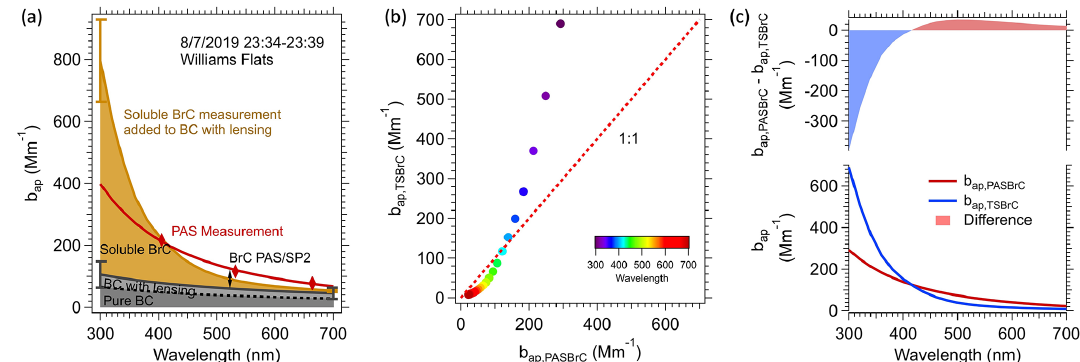
was multiplied by λ